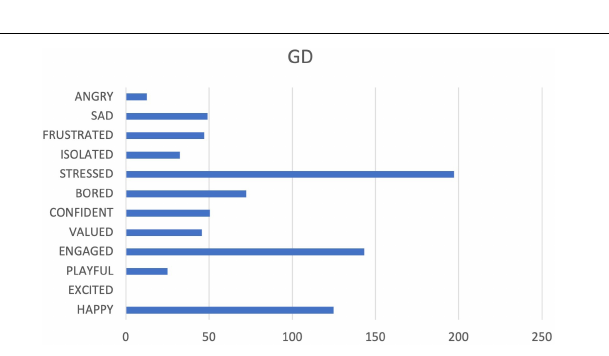
FIGURE 12 | Cumulative frequencies of GD data